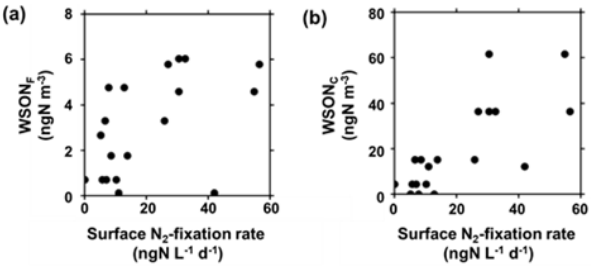
Figure 6. Mass concentrations of (a) WSON F and (b) WSON C as a function of N 2 -fixation rate in SSW. The data of N 2 -fixation rate in SSW were merged into the duration of each corresponding aerosol sampling. For each one aerosol sample, one or more corresponding measurement data of N 2 -fixation rate in SSW were obtained, so that the number of the data points in the panels is more than that of the aerosol